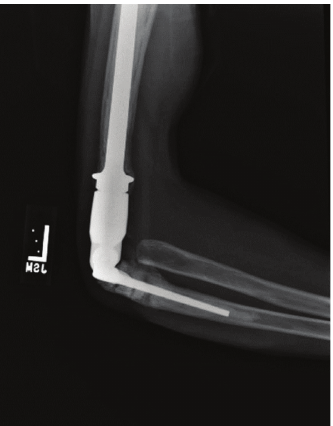
Figure 3: Plain radiograph taken at the patient’s 4.5-month appoint- ment reveals a healed ulna nonunion and a stable total elbow prosthesis without signs of